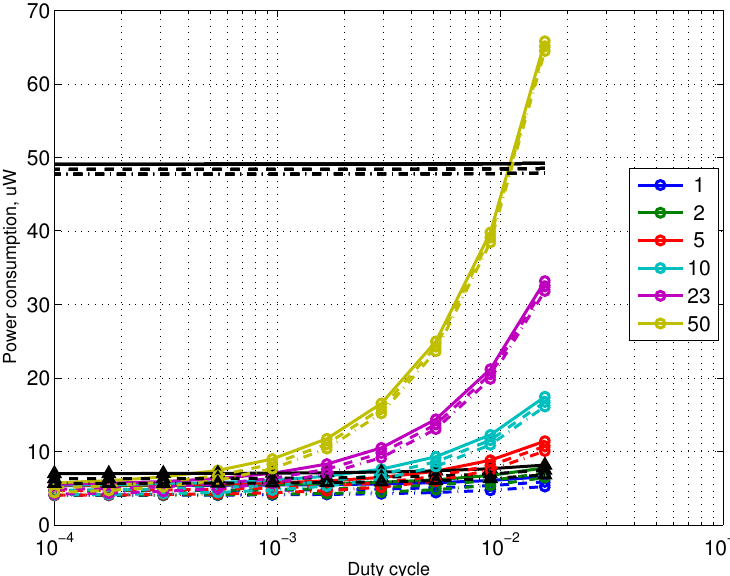
Figure 7. When M t = 1 and M r = 1, power consumption while operating with reloading the capacitor while operating with capacitor ( C s = 0.35 F). Non-WuR in black (without triangles), passive WuR in colors indicating number of nodes for different host duty cycles per node ( β (cid:48) w ). Semi-passive WuR in black with triangles. Line type indicates used SC leakage current model as —: upper , - - -: median, and -.-.-: